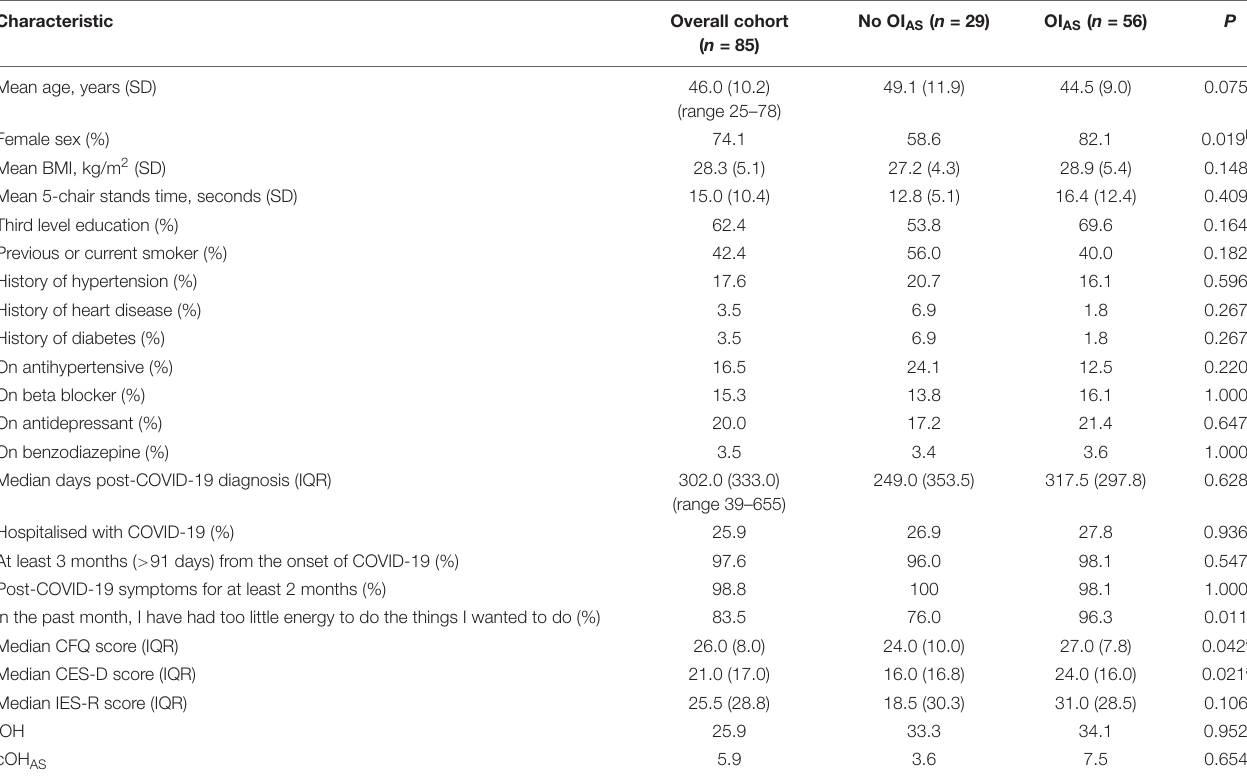
TABLE 1 | | Clinical characteristics of the overall cohort, as well as comparison between OI AS and non-OI AS subgroups. Characteristic Overall cohort